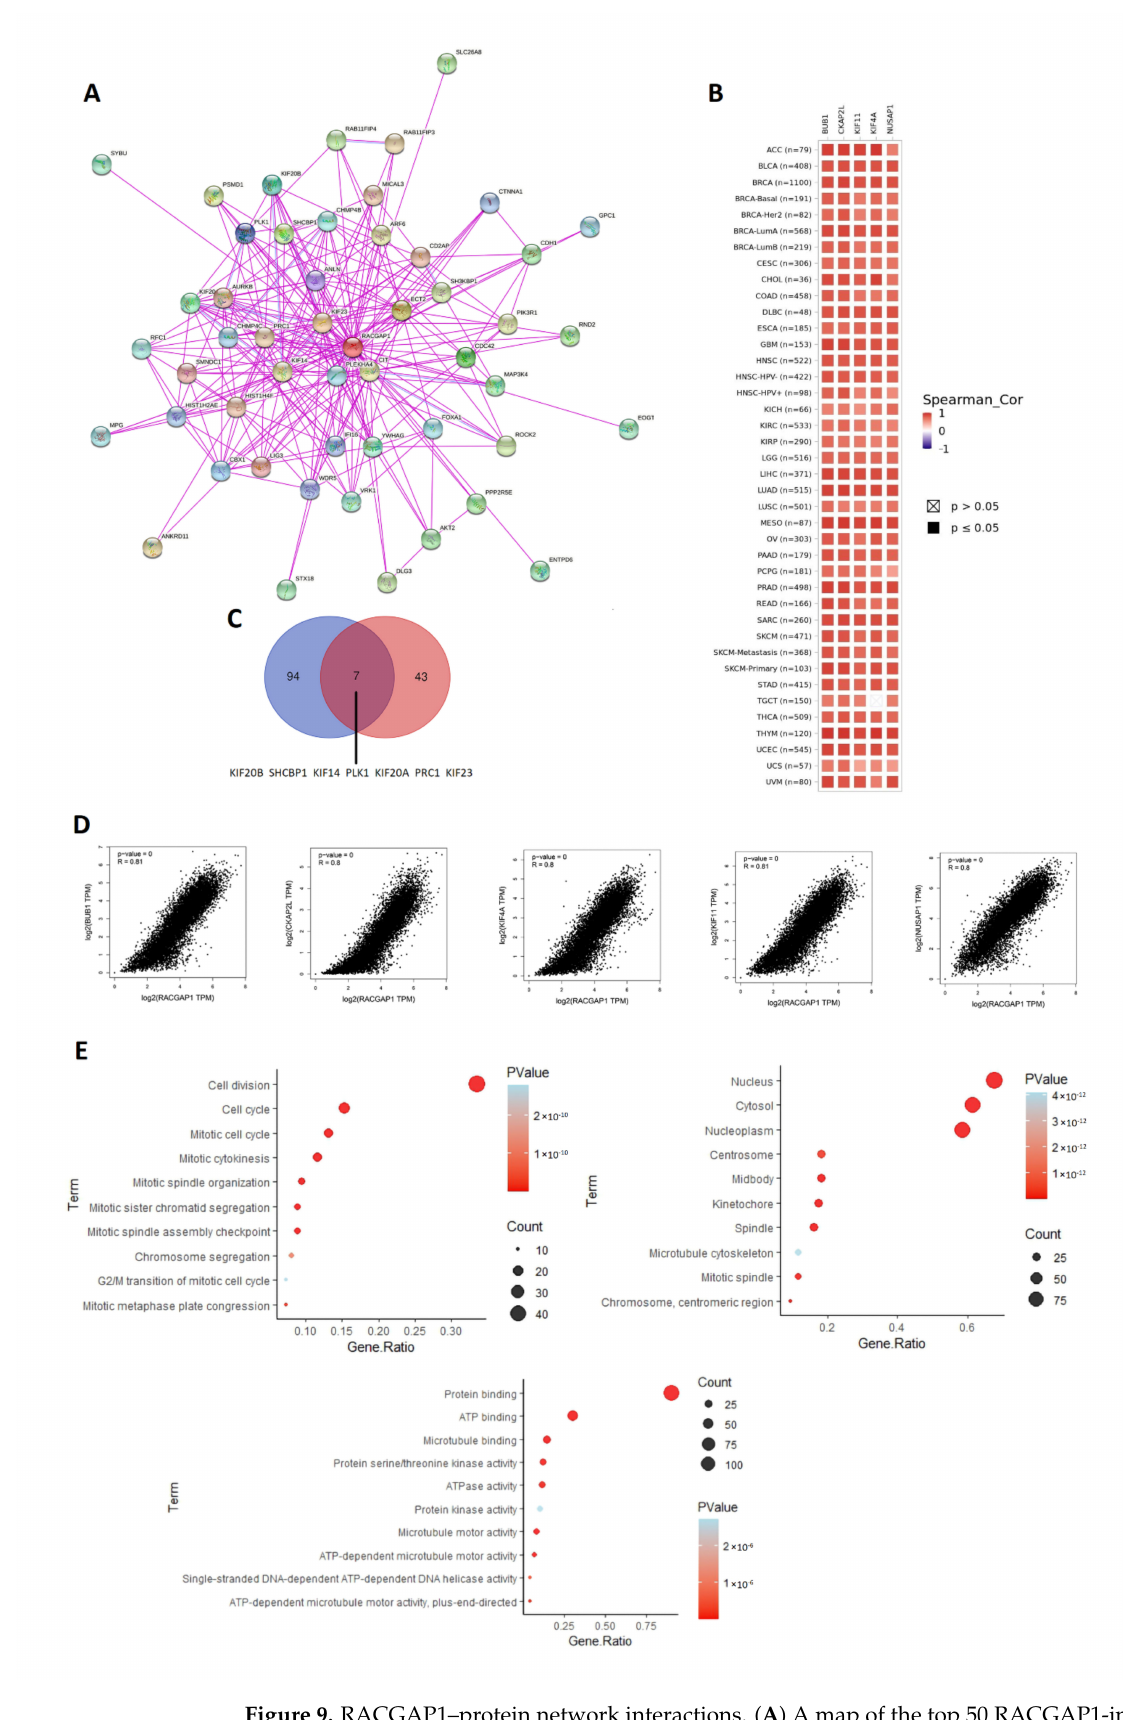
Figure 9. RACGAP1–protein network interactions. ( A ) A map of the top 50